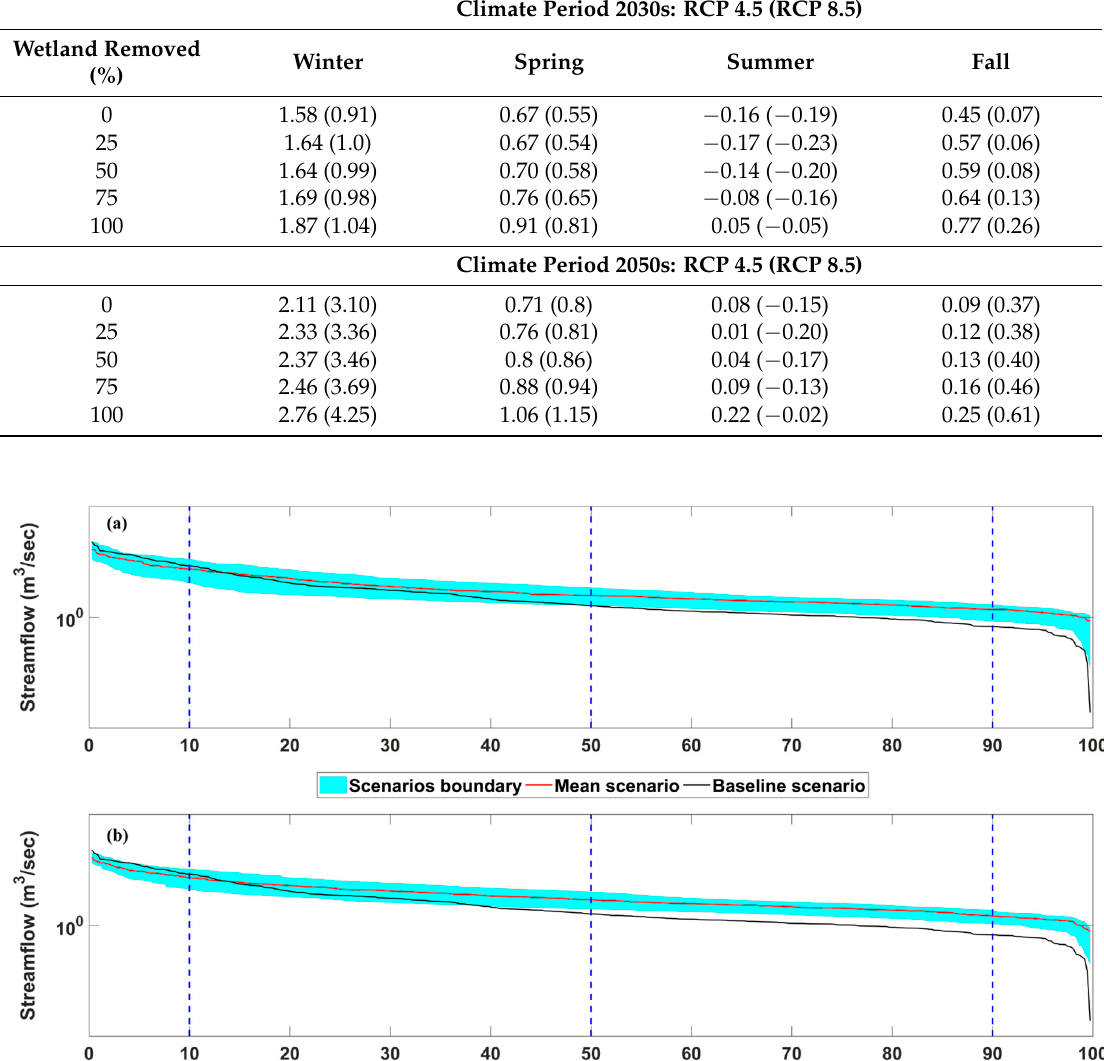
Table 4. Seasonal changes (in %) in streamflow relative to baseline, for various land use scenarios under a changing climate.